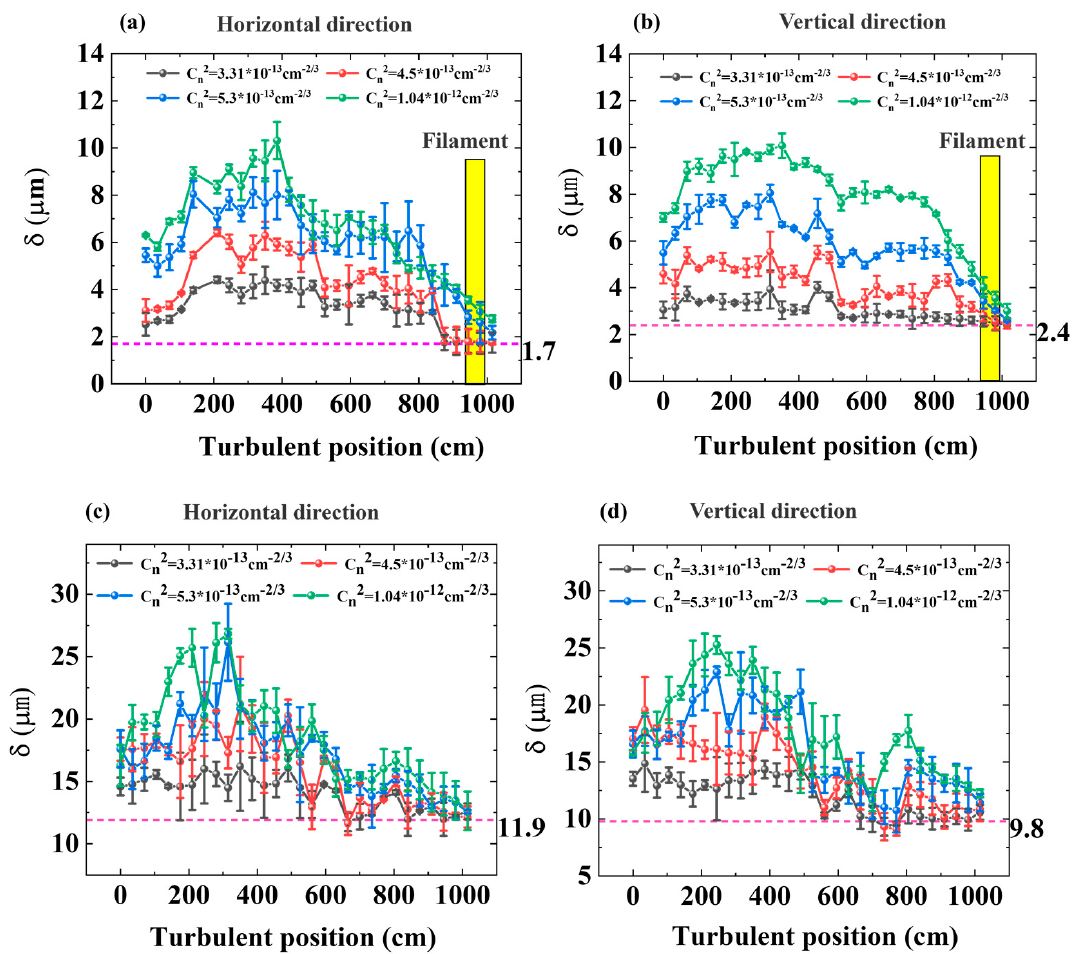
Figure 4. ( a , b ) Horizontal and vertical standard deviations of the beam center vary with the turbu- lence position under four turbulence strengths. Nonlinear transmission yellow rectangles represent the filamentation areas); ( c , d ) linear transmission. The pink baseline (dashed line) represents the hori- zontal and vertical standard deviations of the beam center under linear and nonlinear propagation conditions without artificial turbulence